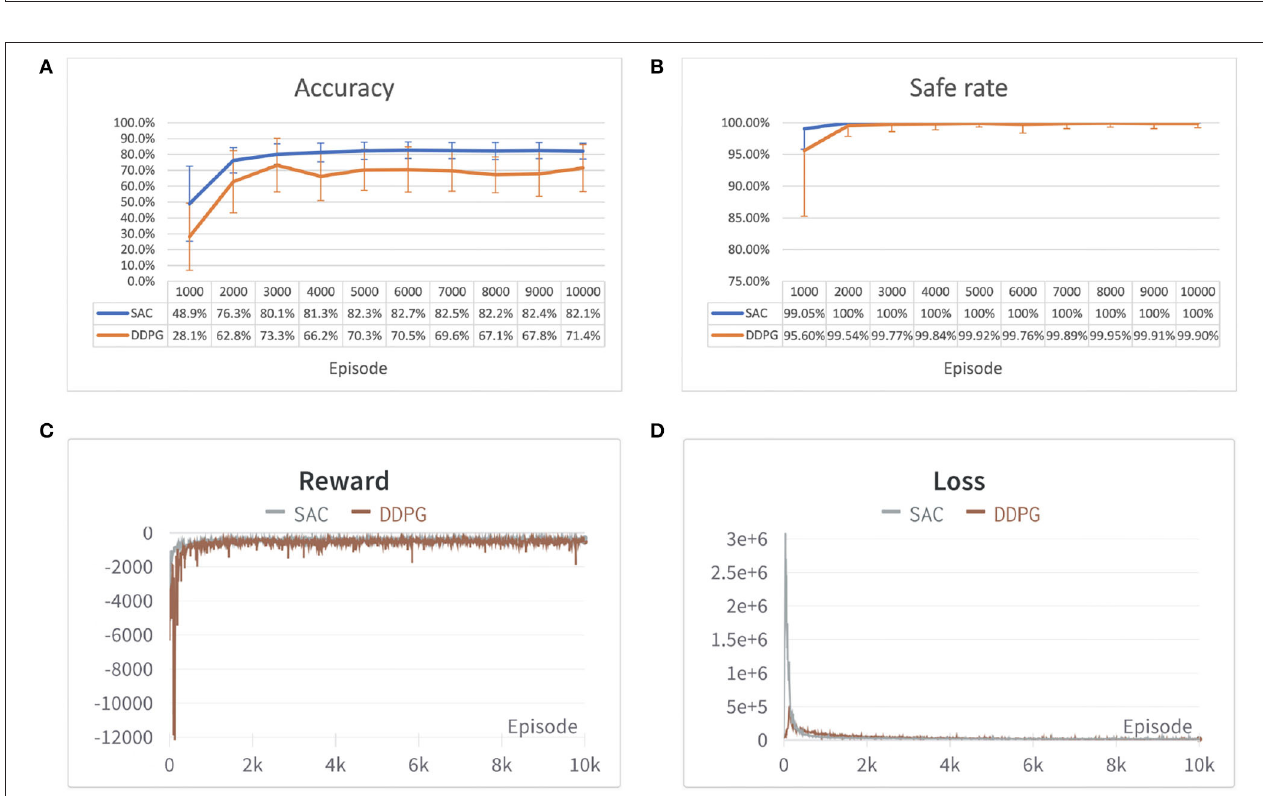
FIGURE 6 | From left to right, first, the robot learns to reach the goal. Second, avoid collisions with dynamic obstacles. Third, keep reaching the goal.